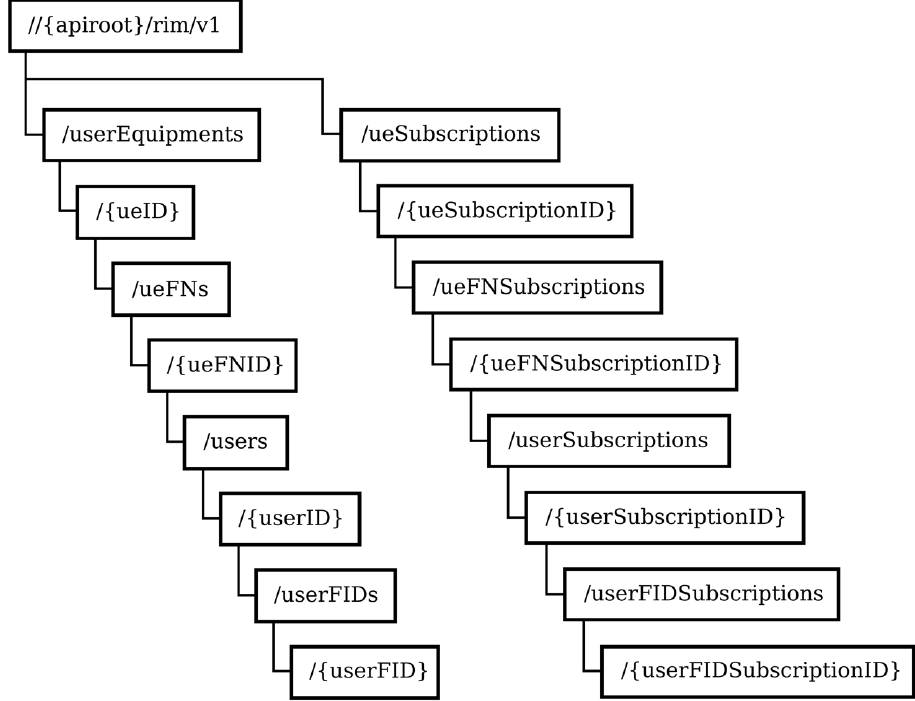
Figure 5. FRMCS resource URIs related to the role management and presence service. Each user device (ueID) is uniquely identified. Some user devices have a functional number/identity (ueFNID) that indicates where the device is used. To be reachable, each user has to register their unique functional number (userID) and one or more functional identities (userFID). The registration and presence status are attributes of the resources and represent individual identities. The subscription resources represent existing subscriptions to notifications about changes to the registration or presence status of the respective identity. The registered identifications and current presence information allow/disallow the use of critical communication